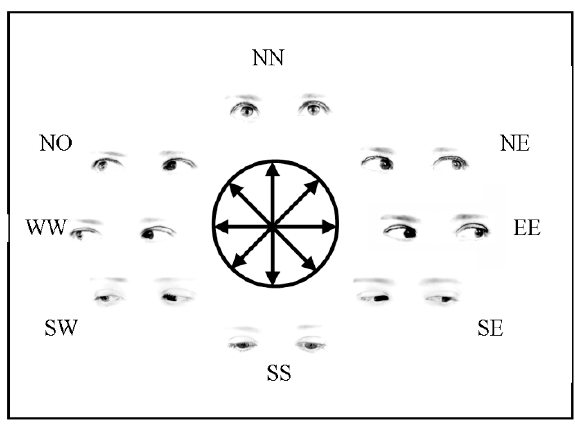
Figure 7. The stimulus type “gaze” used in Experiment 2, displaying the eight directions conveyed by the different stimuli and the eight possible positions of stimulus presentation. The other stimulus types (i.e., “line” and “arrow”) were the same as in Experiment 1.